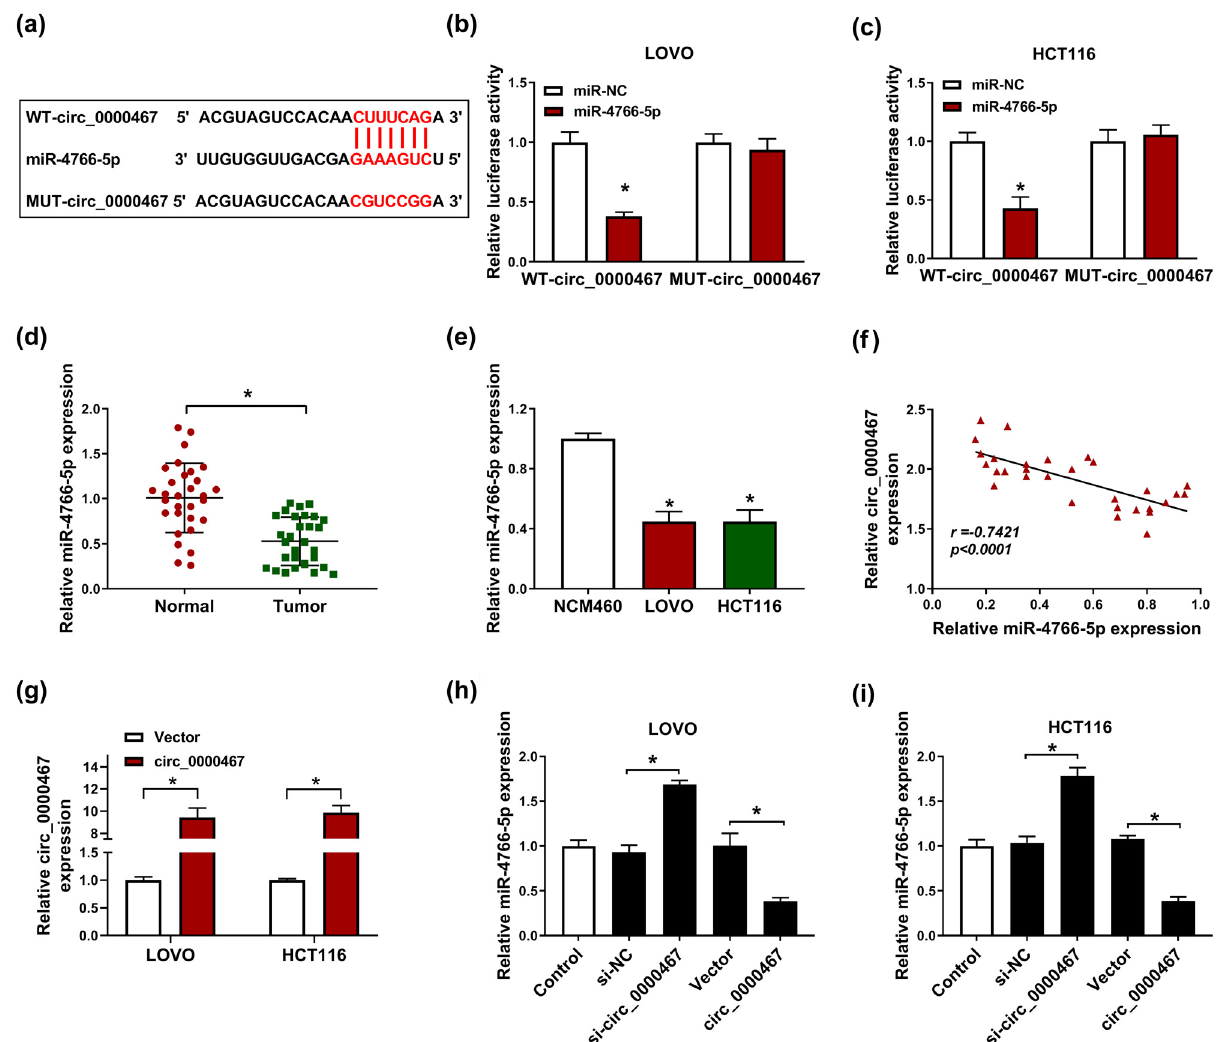
Figure 3: circ_0000467 functioned as a sponge of miR - 4766 - 5p in CRC cells. ( a ) The presumptive binding sites between circ_0000467 and miR - 4766 - 5p were predicted by Starbase. ( b and c ) The relative luciferase activity of LOVO and HCT116 cells co - transfected with WT - circ_0000467 or MUT - circ_0000467 and miR - 4766 - 5p or miR - NC was measured by the dual - luciferase reporter system. ( d and e ) miR - 4766 - 5p expression was assayed by RT - qPCR in CRC tissues ( d ) and cells ( e ) . ( f ) The relationship between circ_0000467 and miR - 4766 - 5p was analyzed with Pearson ’ s correlation coe ffi cient. ( g ) The overexpression e ff ect of circ_0000467 vector on circ_0000467 was detected through RT - qPCR. ( h and i ) The expression of miR - 4766 - 5p was determined in LOVO and HCT116 cells with circ_0000467 overexpression or downregulation using RT - qPCR. * P <